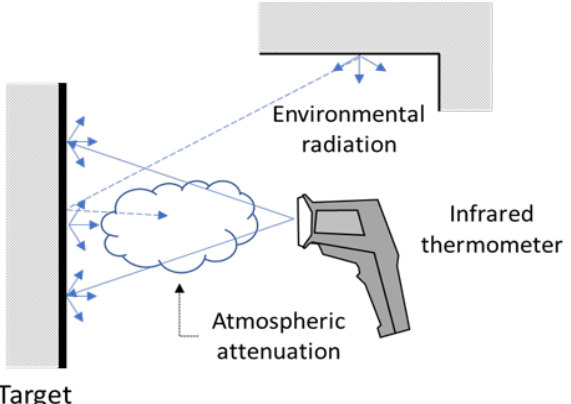
Figure 8. Other influence factors .